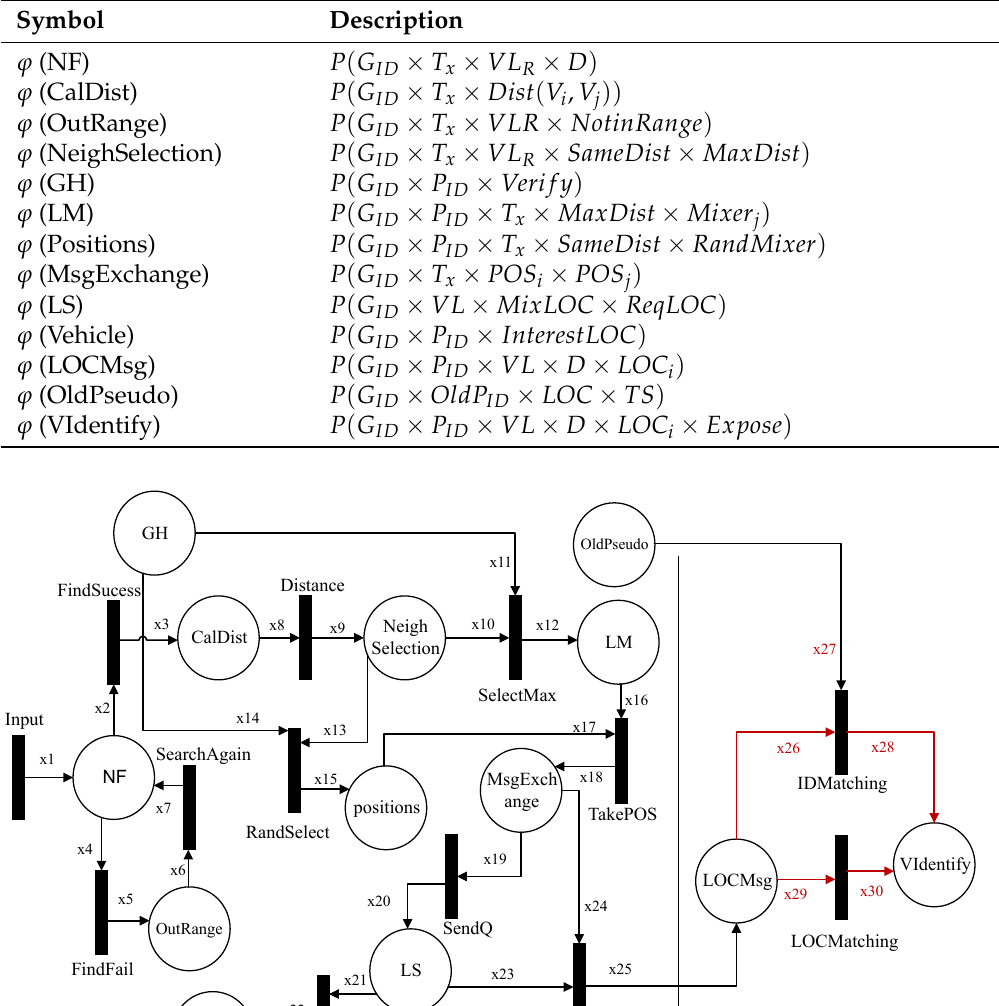
Table 7. Places used in HLPN for position-mixing method.